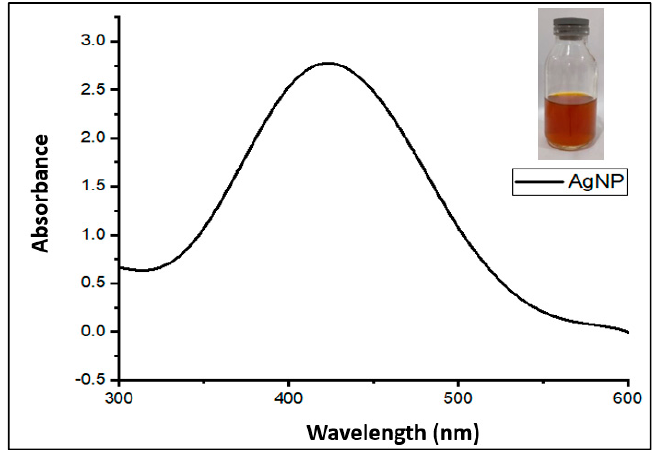
Figure 4. UV-Vis absorption spectrum of silver nanoparticles.